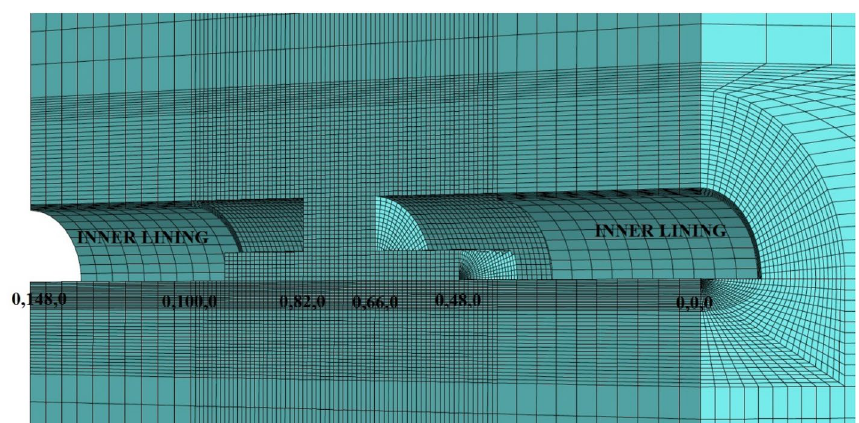
Figure 18. Tunnel excavation situation after stage